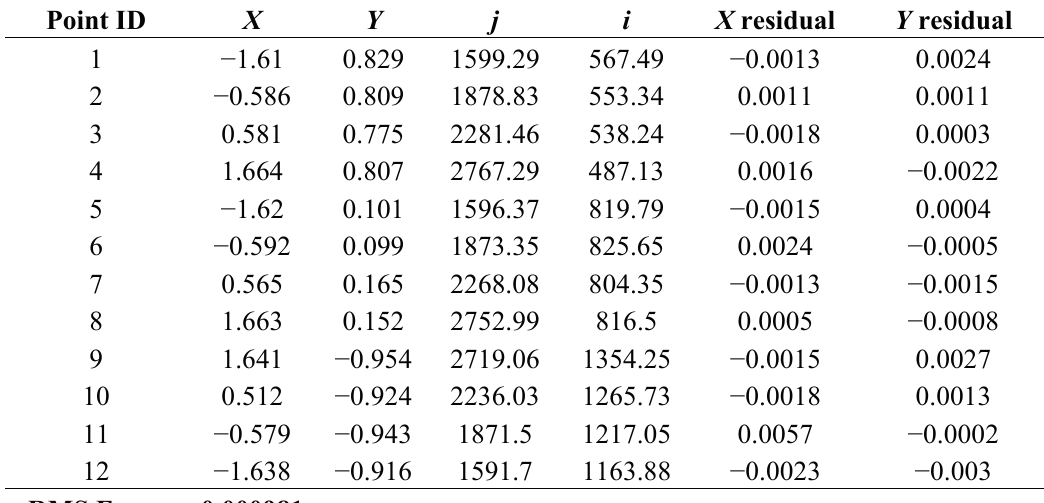
Table 10. Ground, image coordinates and their ground residuals of the undistorted NIKON D100